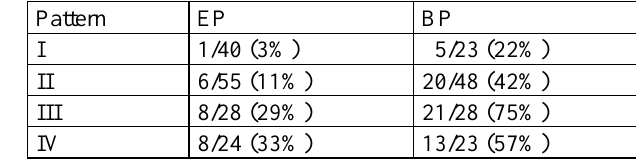
Table 2. Overt subjects according to structural